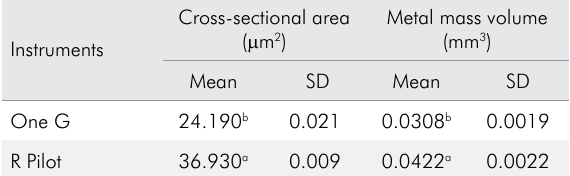
Table 2. Mean values of cross-sectional area ( μ m 2 ) and